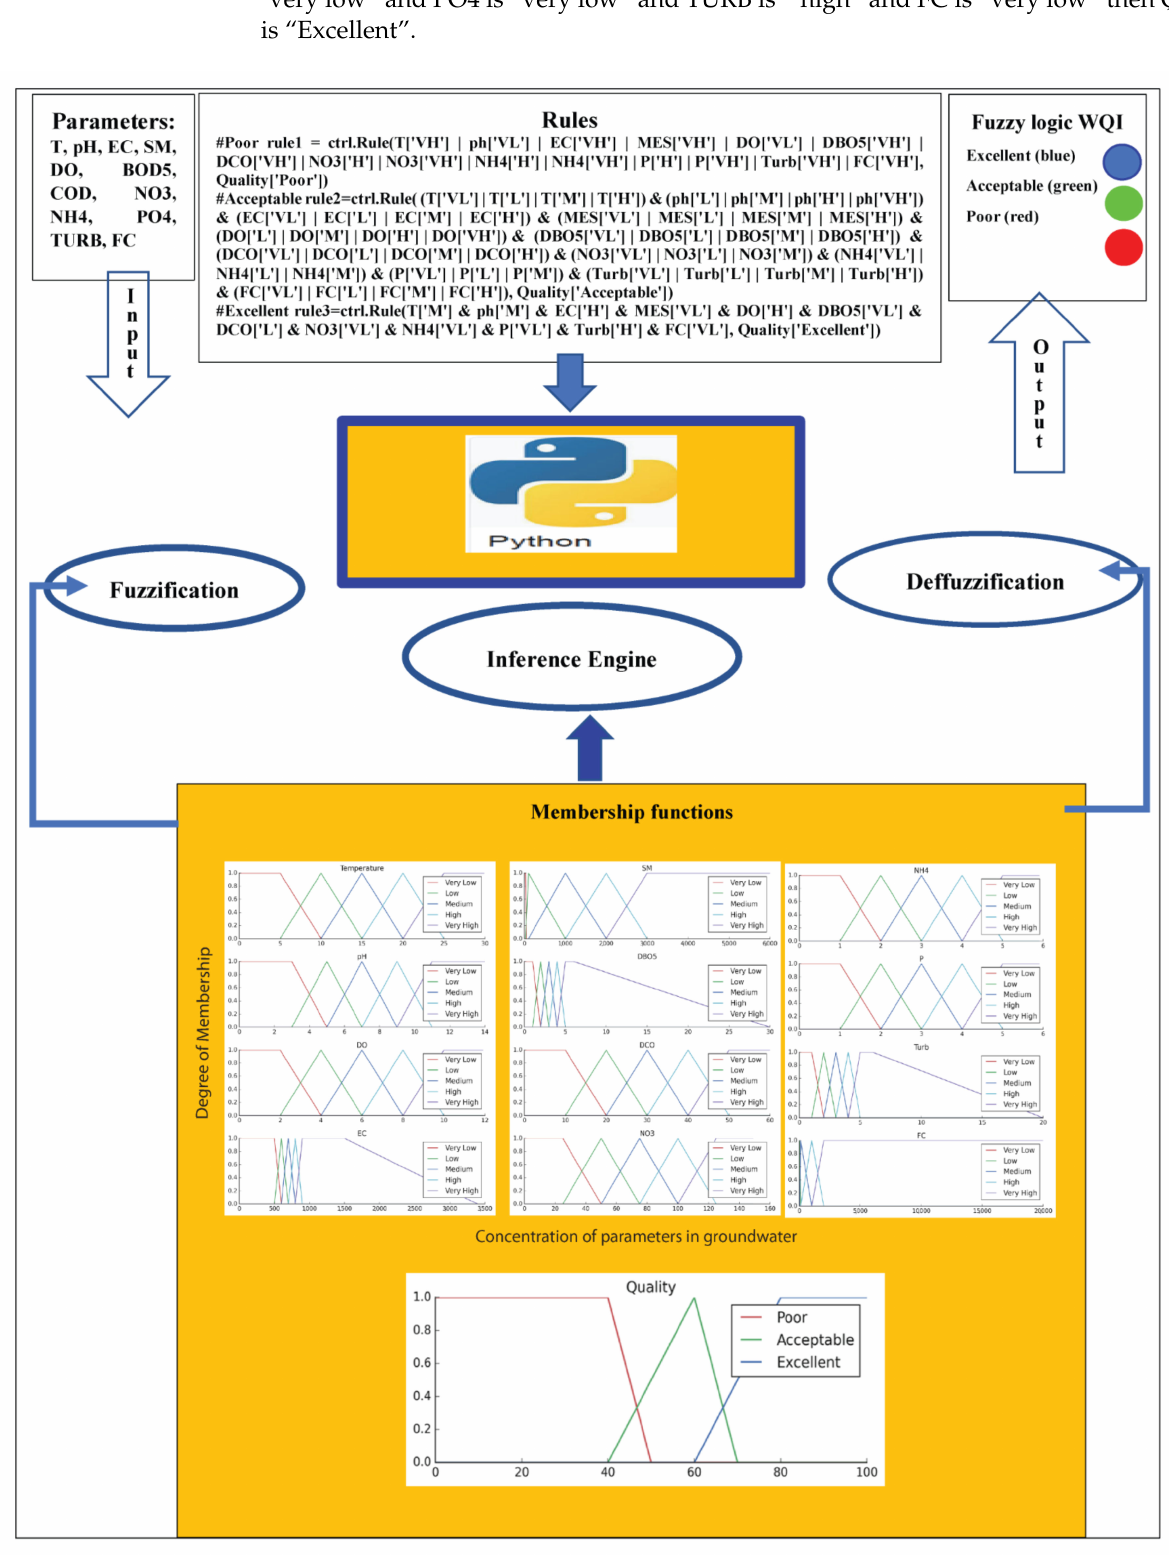
Figure 4. Different components of the fuzzy logic